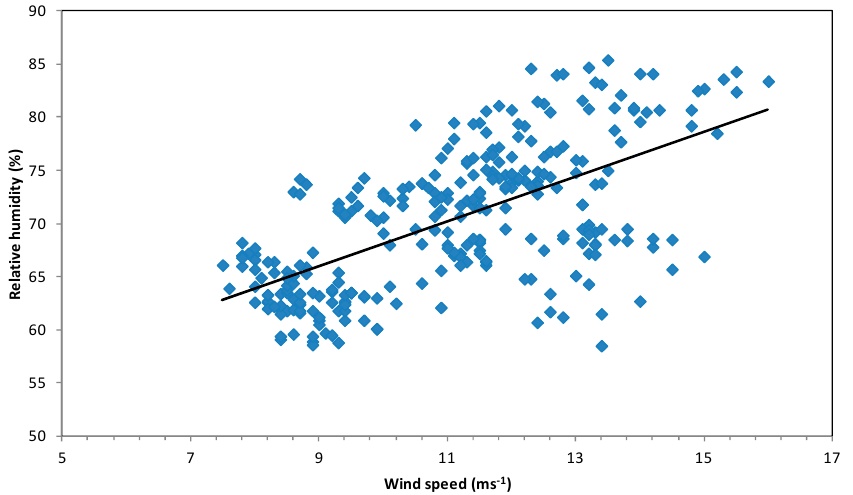
Figure 11. Variation of the relative humidity versus wind speed for an onshore wind direction (marine air mass episode). The data were recorded on the island of Porquerolles by Piazzola (personal communication). The black line fits the data.